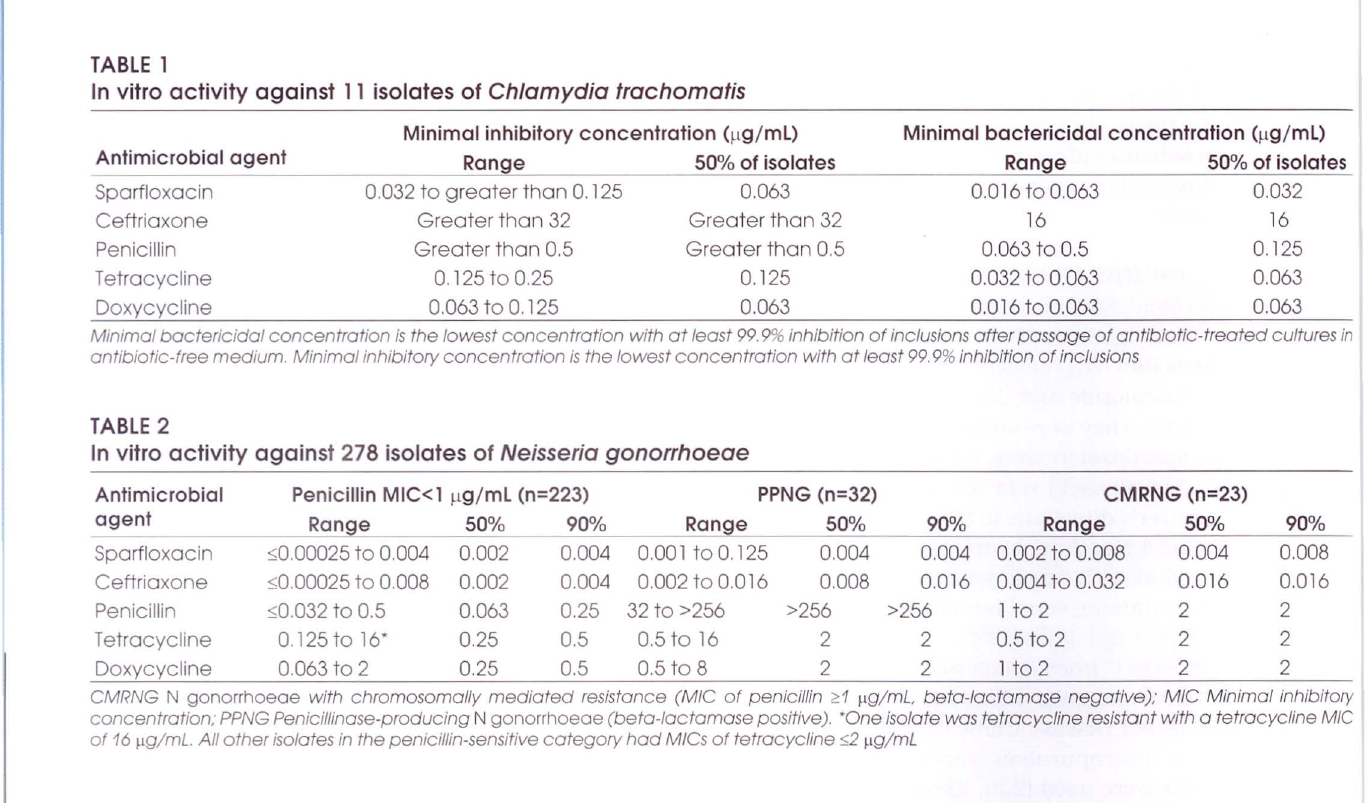
In vitro activity against 11 isolates of Chlamydia trachomatis Minimal inhibitory concentration (µg/ml)